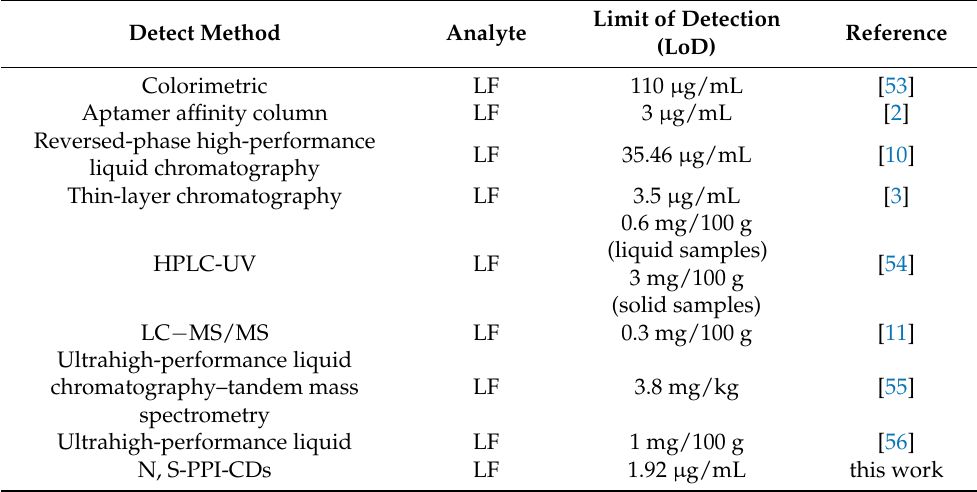
Figure 8. ( a ) PL response of N, S-PPI-CDs with different concentrations of lactoferrin (LF) (Inset: photographs of N, S-PPI-CDs solution under UV (365 nm) irradiation after adding LF (0 and 10 µ g/mL), respectively.); ( b ) Stern–Volmer plot of N, S-PPI-CDs toward LF. Table 2. Different detect methods in the literature for LF detection.